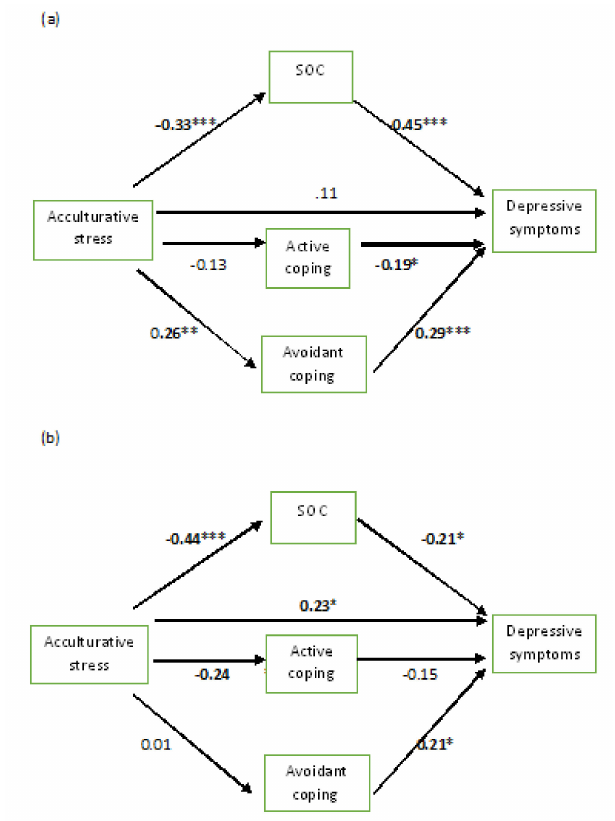
Figure 3. Direct and indirect e ff ects of acculturative stress on depressive symptoms through SOC, avoidant coping, and active coping among: ( a ) Year 1 + 2 Arab students; and ( b ) Year 3 + 4 Arab students. Note . All of the coe ffi cients in the figures are standardized. * p < 0.05; ** p < 0.01; *** p < 0.001; SOC, sense of